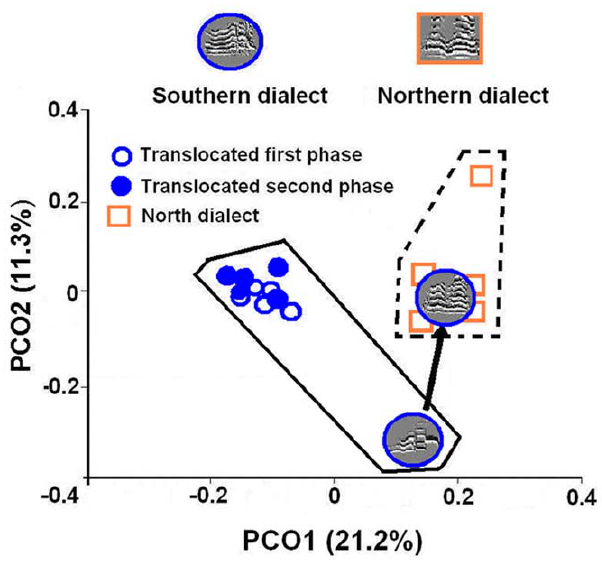
Figure 2. Plot of PCO from contour cross-correlations for calls of yellow-naped amazons. Dashed line delimitates Northern dialects sound space, solid lines delimitate Southern dialect sound space. Points for the vocal imitating individual are illustrated with representative spectrograms, and movement between phases indicated by an arrow. Spectrograms on top show examples of contact calls of residents of the Northern dialect (squared) and translocated individuals from the Southern dialect